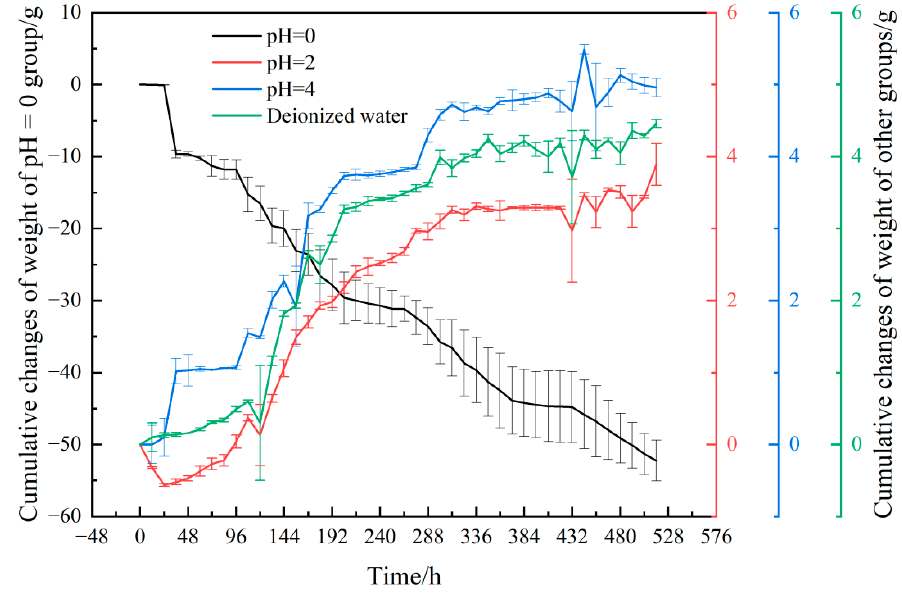
Figure 4. Changes of weight of lamprophyre samples in different solutions.